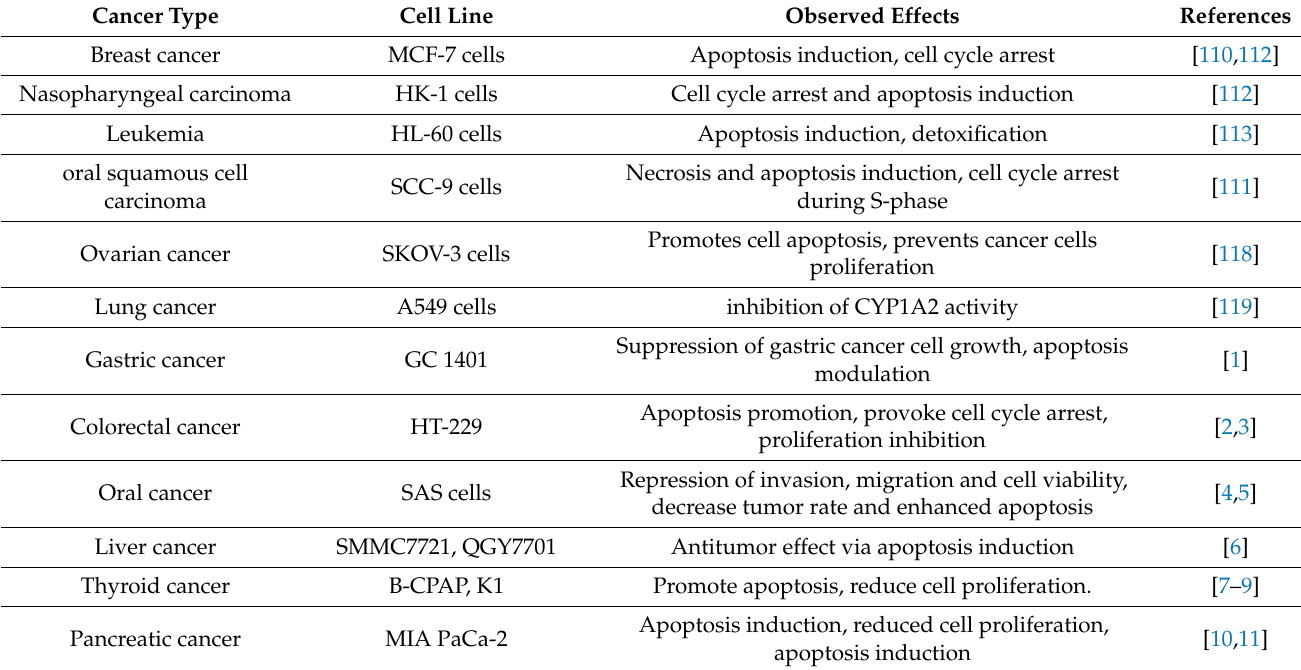
Table 1. Effect of quercetin on multiple